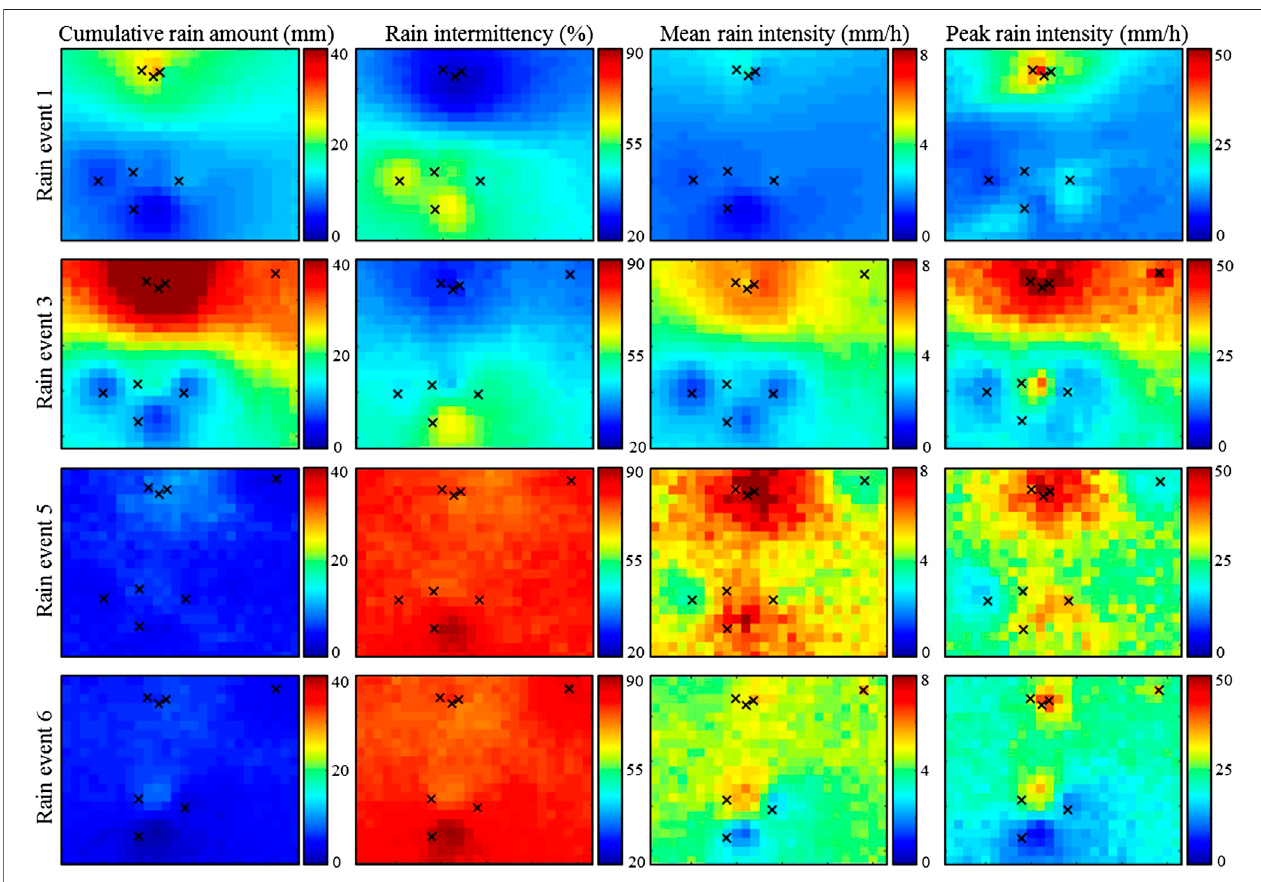
FIGURE 7 | Summary statistics of the spatial behavior of the four signi fi cant rainstorms recorded during the experiment. From top to bottom: event 1, 3, 5 and 6. From left to right: rain accumulation, intermittency, mean intensity and peak intensity. In all plots, black crosses denote active rain gauges.